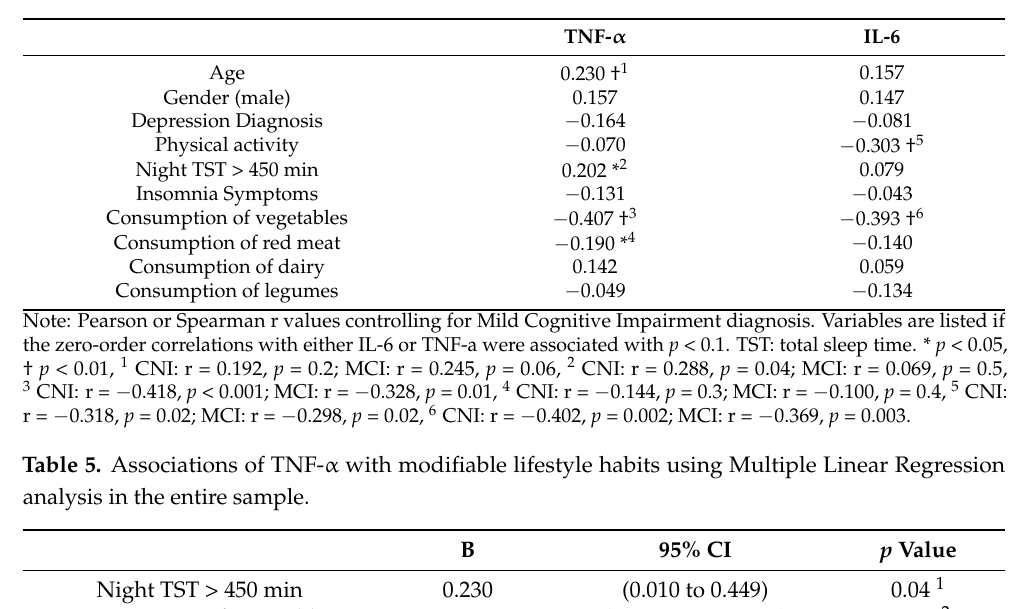
Table 4. Partial correlations of demographic, clinical, sleep, and lifestyle parameters with proinflam- matory cytokine levels in the entire sample.